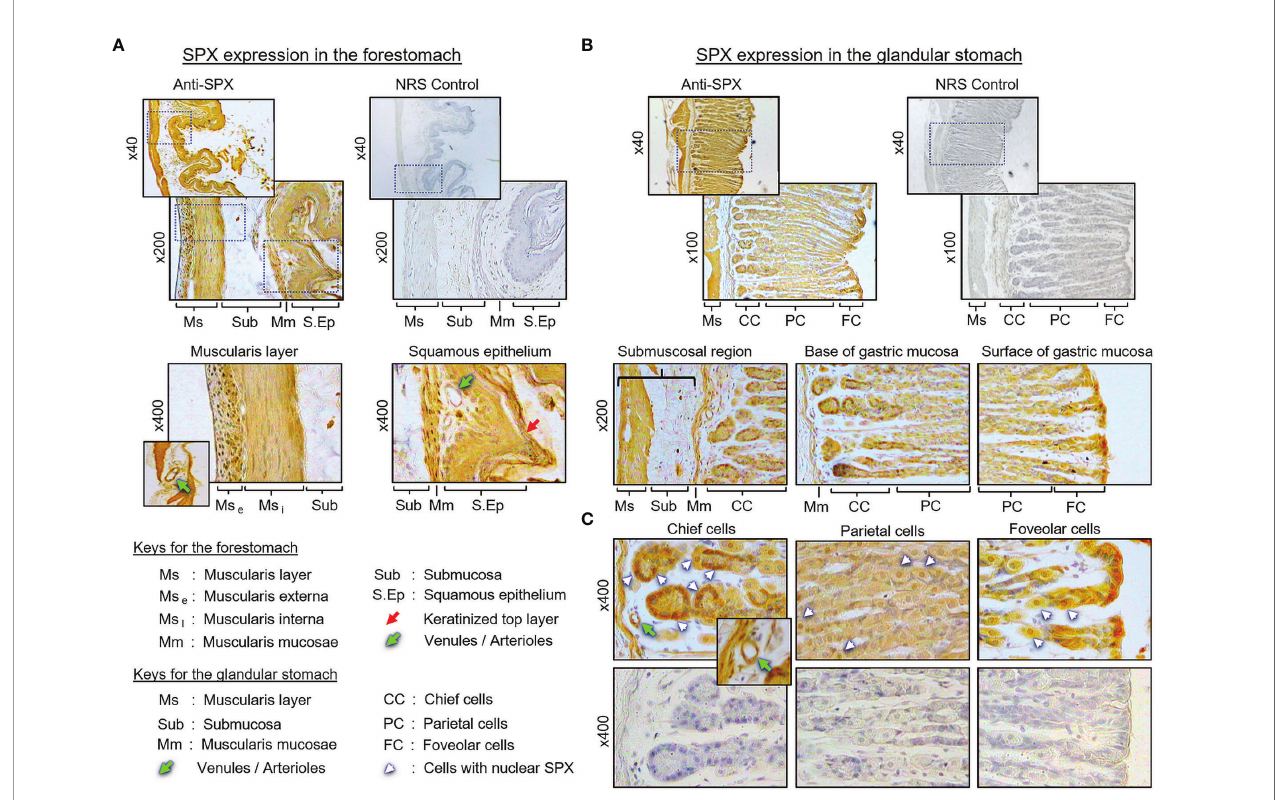
FIGURE 5 | Histological distribution of SPX expression in the mouse stomach. (A) SPX expression in the forestomach. SPX immunoreactivity detected by anti-SPX was located in the muscularis layers and squamous epithelium, especially in muscularis externa, muscularis interna, muscularis mucosae, and squamous cell layers (including the keratinized layer on the top). (B) SPX expression in the glandular stomach. SPX signals were identi fi ed in the same muscularis layers as well as in the gastric glands of the mucosal layer. (C) SPX expression within the gastric mucosa. SPX immunostaining was observed in the foveolar cells, parietal cells and chief cells of the gastric glands. In the forestomach and glandular stomach, SPX signals were also noted in the endothelial cells and muscle layer of the venules/arterioles within/associated with the muscularis layers (insets). Parallel staining with NRS was used as negative control and the numbers shown on the side of individual panels (×40, ×100, ×200¸ and ×400) represent the magni fi cation for the respective